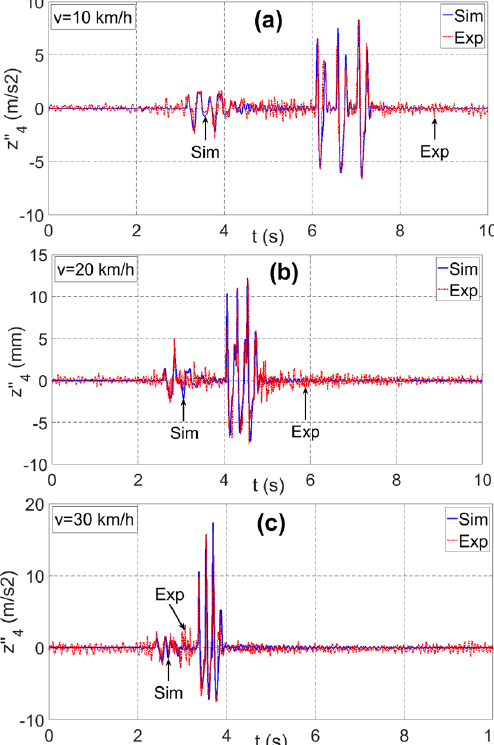
Figure 9. Acceleration of the vehicle body at the 4th axle (z”4): ( a ) at 10 km/h, ( b ) at 20 km/h, Figure 9 . Acceleration of the vehicle body at the 4th axle (z ″ 4): ( a ) at 10 km/h, ( b ) at 20 km/h, ( c ) at